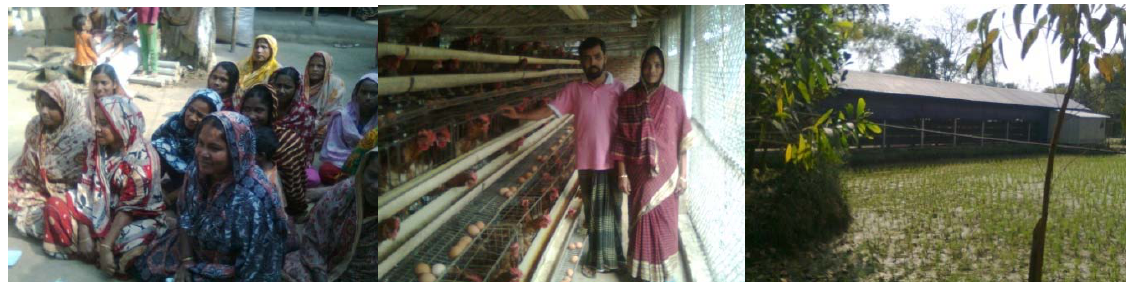
Figure 2. Microfinance group meeting and beneficiaries of microfinance and poultry farm microenterprise in